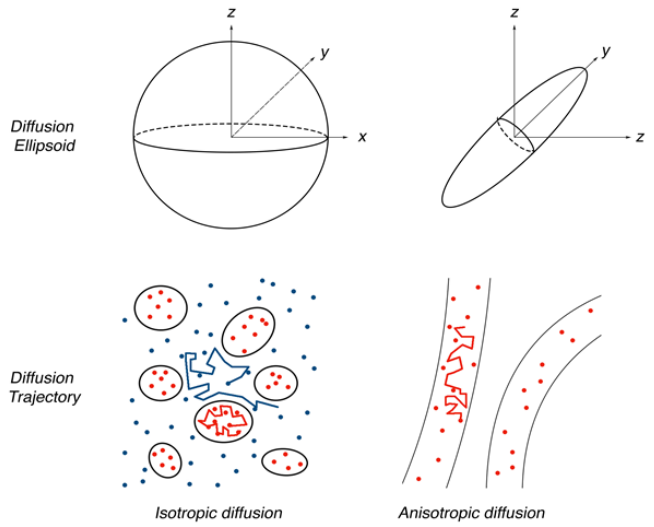
Figure 1. Example of ellipsoidal diffusion tensors depending on the behaviour of water molecules in different tissue microstructures.